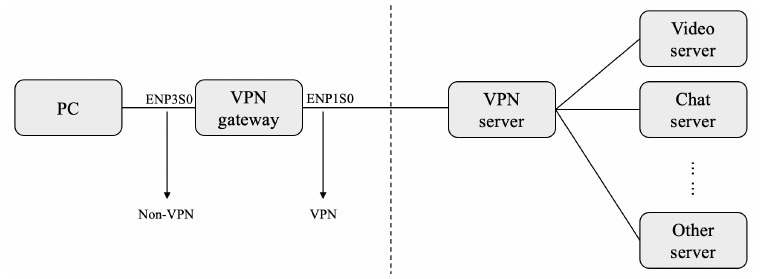
Figure 6. Network environment of the captured dataset.